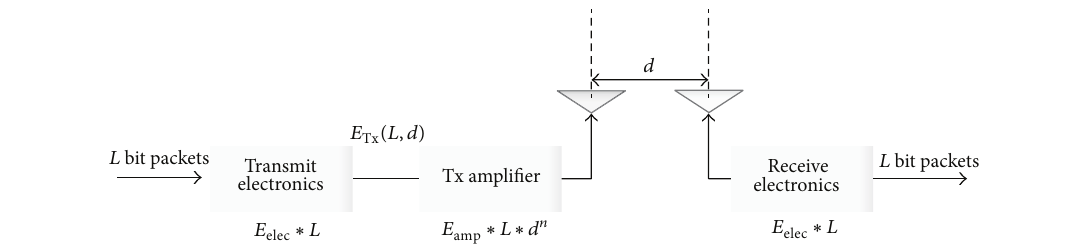
Figure 3: Radio energy dissipation model.